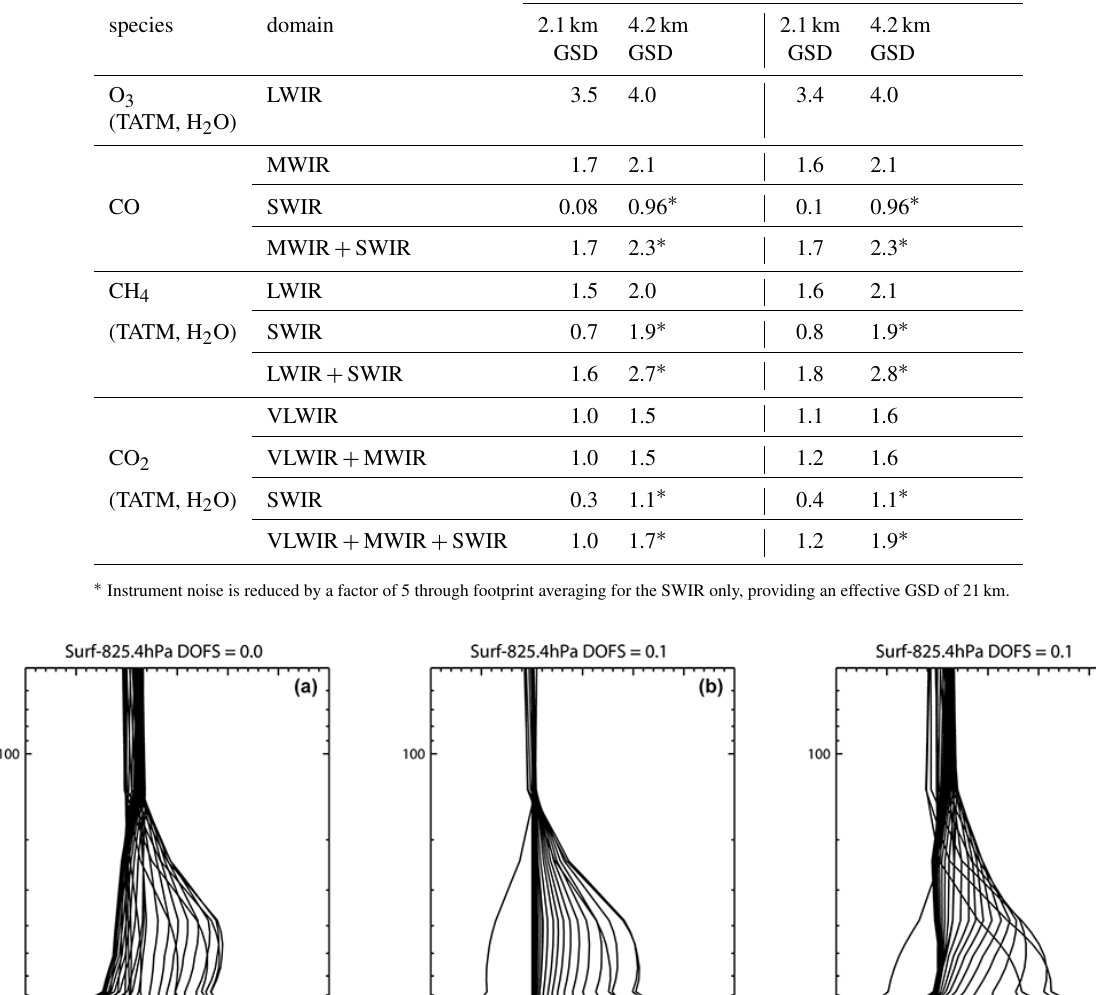
Table 7. Trace gas retrieval configurations and DOFS for the West Virginia profile. TATM and H 2 O are simultaneously retrieved when listed. Retrieved Frequency DOFS (MOPD = 2cm) DOFS (MOPD = 0 . 8cm) species domain